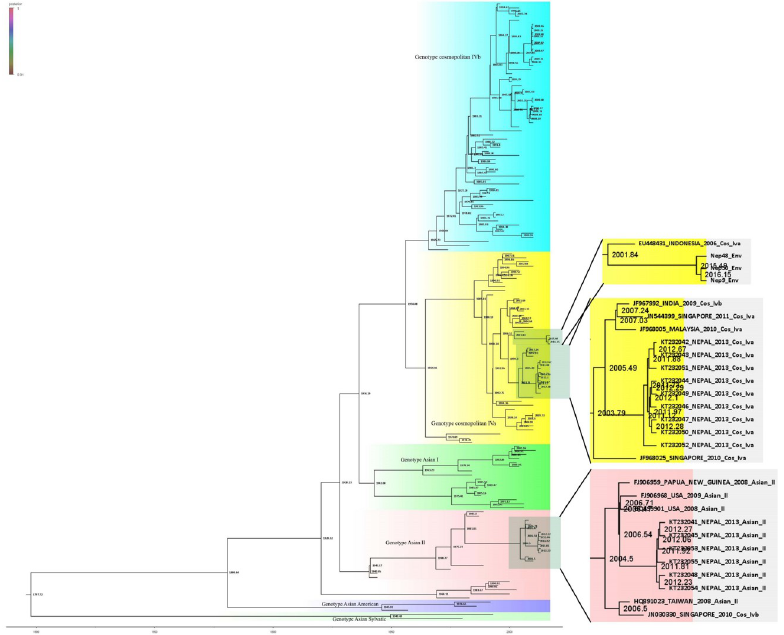
Fig 7. Phylogeny tree of DENV-2 serotype constructed using BEAST v2.5.1 using Gamma+I+T93 substitution model against Dengue genotyping database. Tree are labelled with node age at corresponding node. Detail tree with all of the sequences used for genotyping is shown in S2